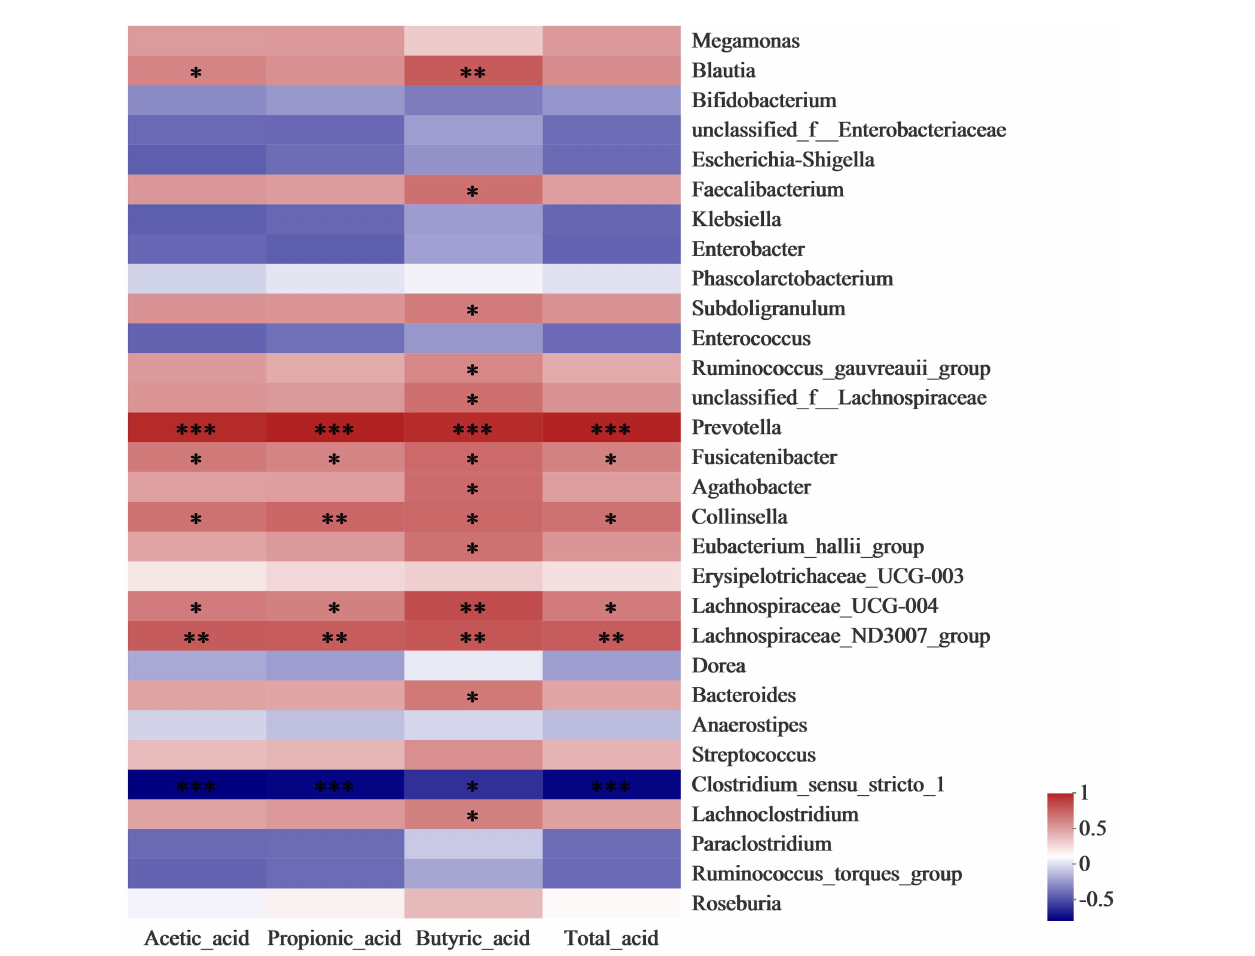
FIGURE 4 Heatmap analysis for correlation between gut microbiota community and SCFAs. * p < 0.05, ** p < 0.01, and *** p < 0.001, respectively; CON, the blank control (no additional carbon source supplement), INU, the positive control (INU supplement), and LDSPs, the experimental group (LDSPs supplement); SCFAs, short-chain fatty